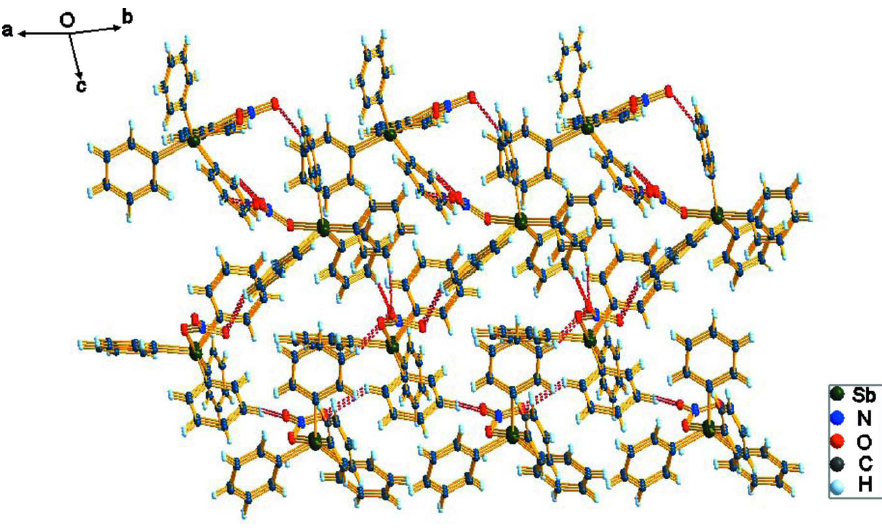
Packing diagram of the title compound showing the three-dimensional network. Intermolecular C—H···O hydrogen bonds are shown as dotted